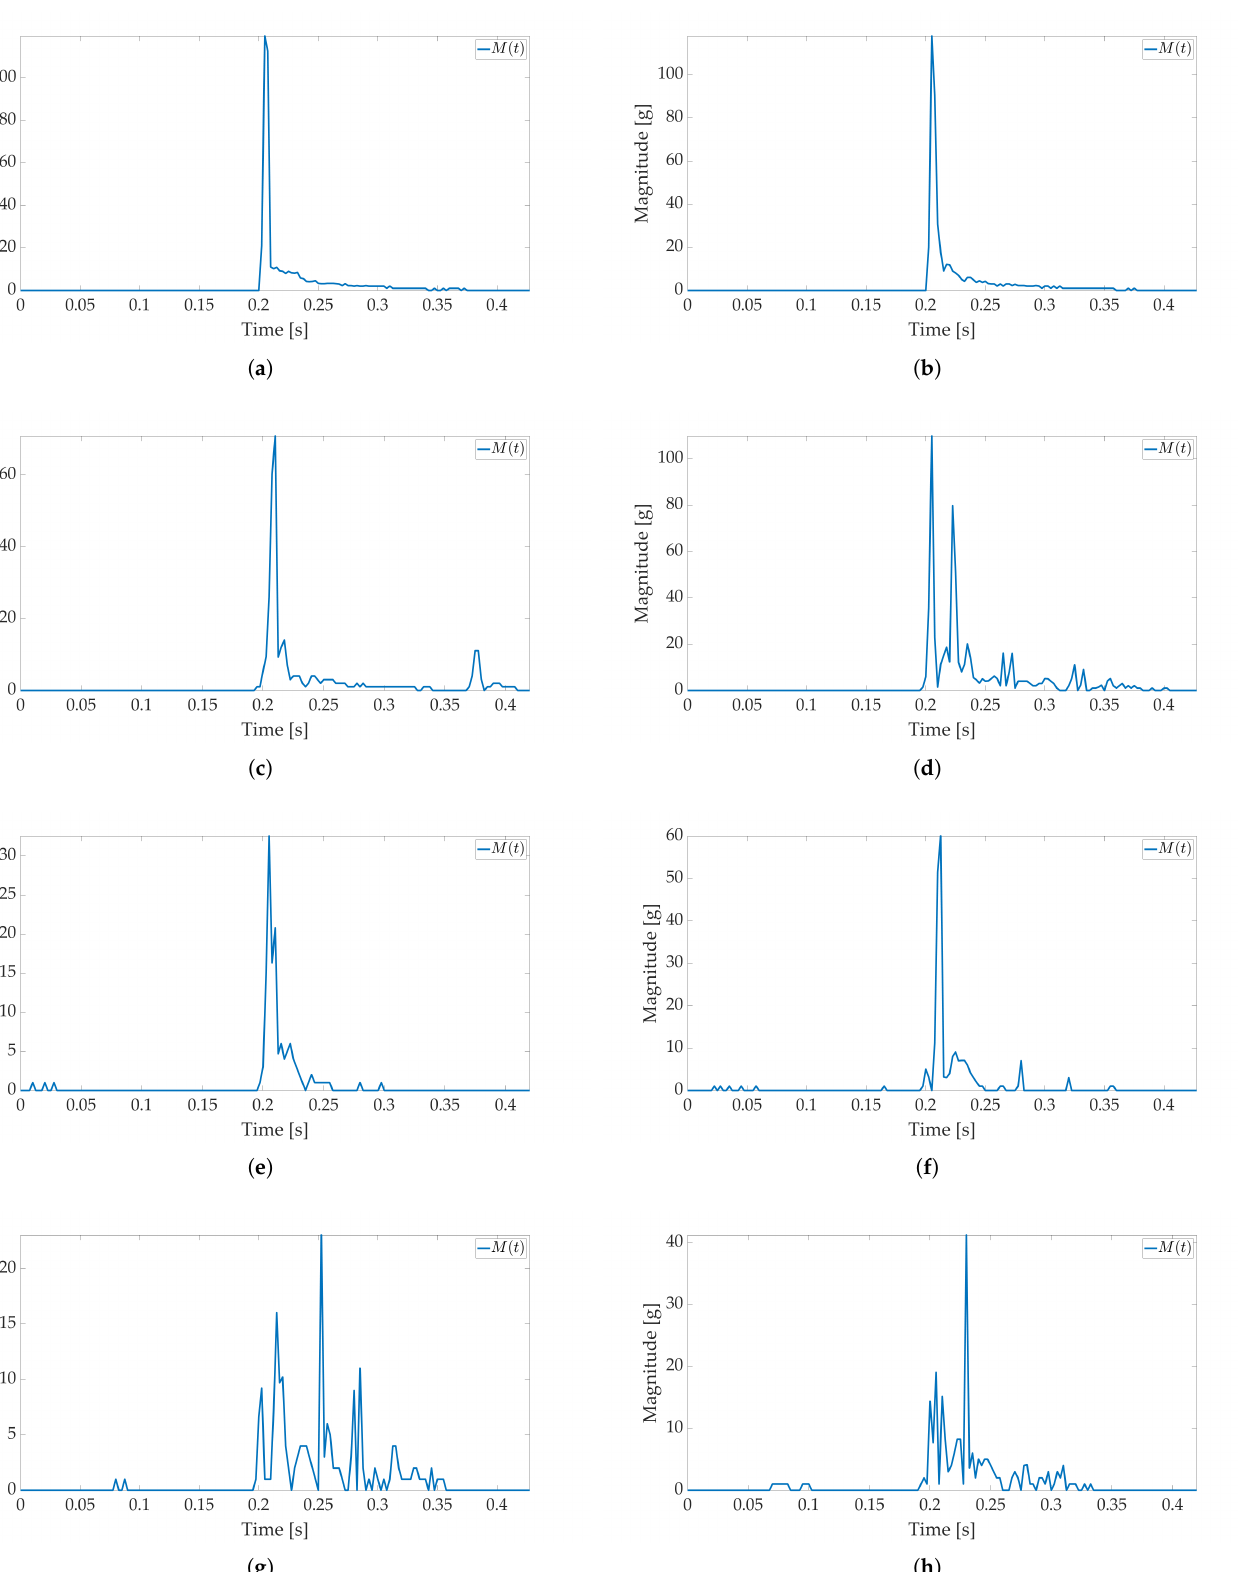
Figure 12. Shock detection values for package falling horizontally from various heights (400 Hz with FIFO). Acceleration magnitude waveform: measured inside the package on figures ( a ) (100 cm), ( c ) (50 cm), ( e ) (20 cm), ( g ) (10 cm); measured on the package on figures ( b ) (100 cm), ( d ) (50 cm), ( f ) (20 cm), ( h ) (10